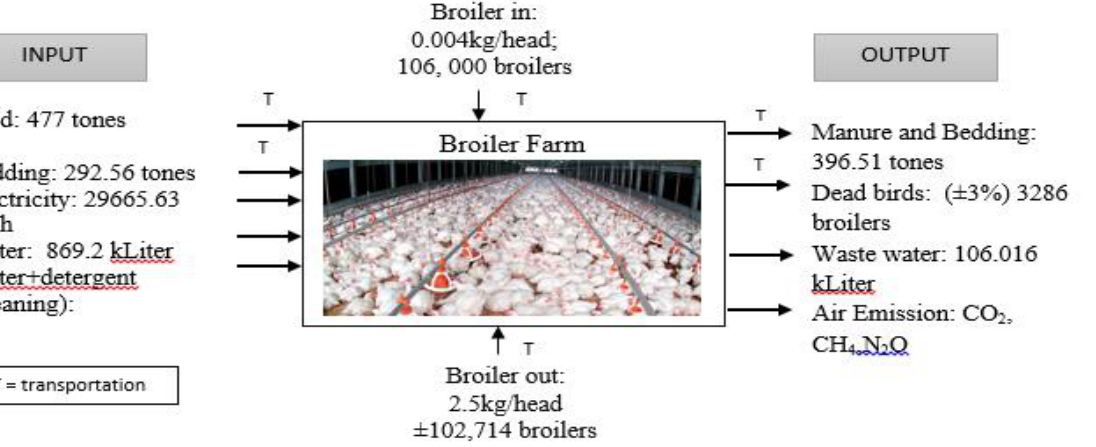
Figure 5: Material flow of broiler chicken production